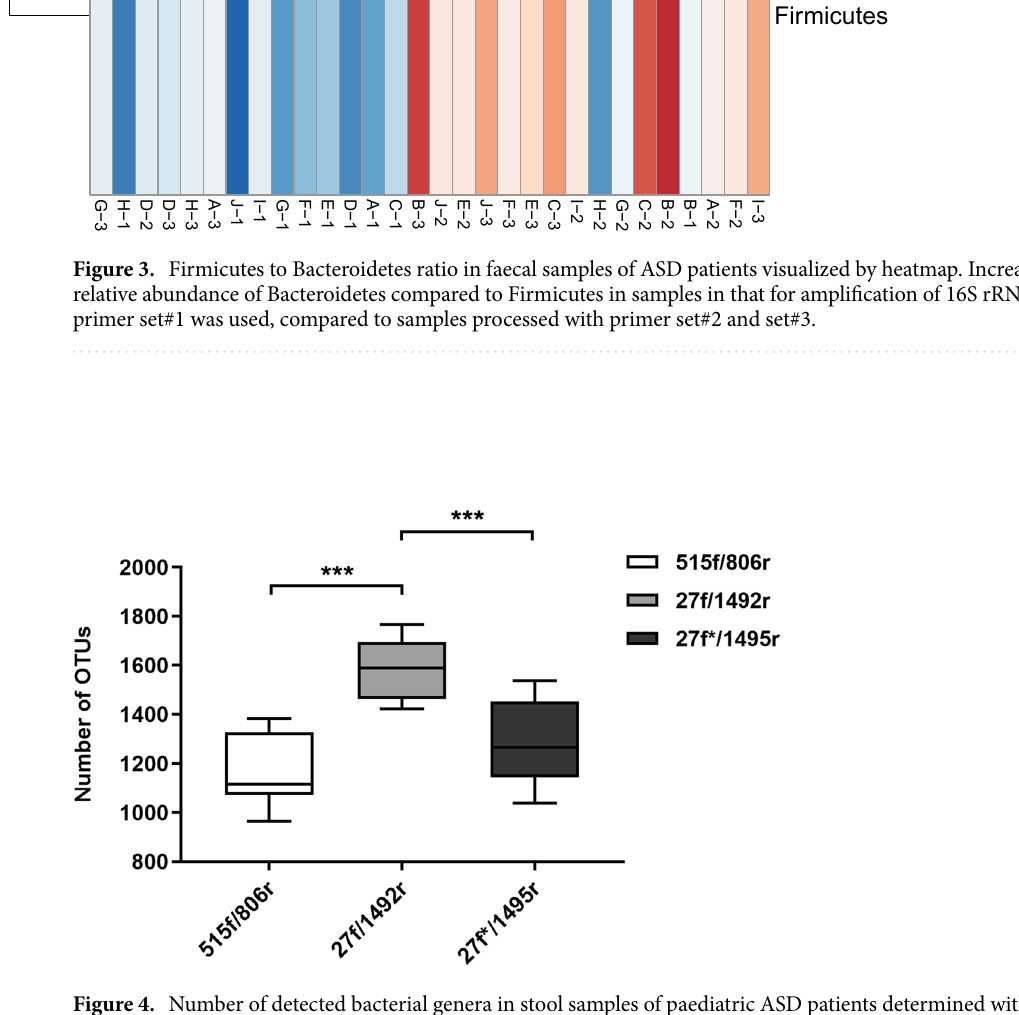
Figure 4. Number of detected bacterial genera in stool samples of paediatric ASD patients determined with three primer sets. Primer set#2 (27f/1492r) matched significantly to more genera than primer set#1 (515f/806r) and set#3 (27f*/1495r). The level of significance ≤ 0.01 was